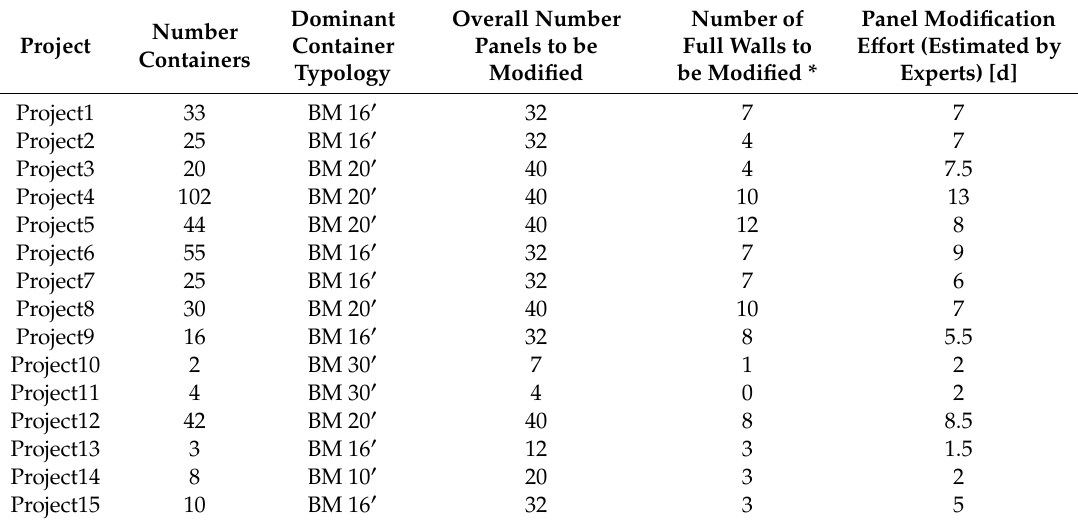
Table 4. Data set for statistical